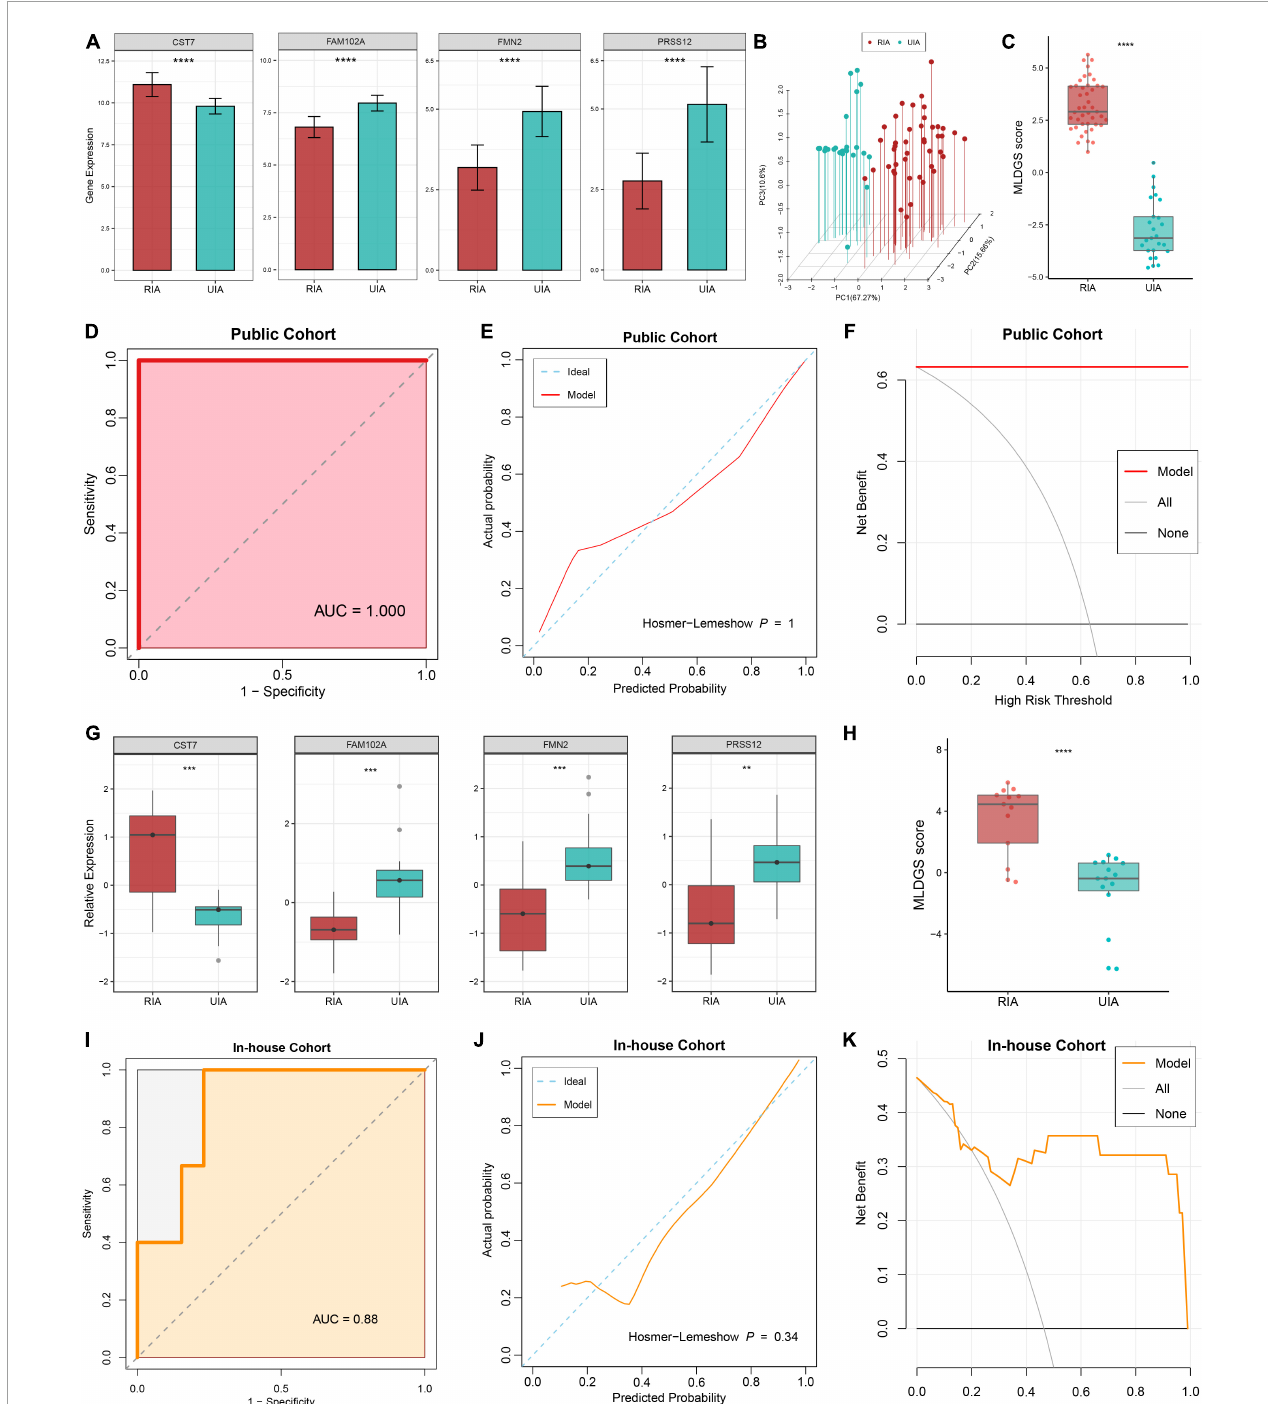
FIGURE4 Evaluation and validation of the MLDGS model. (A) Differential expression of four model genes between RIA and UIA groups in public cohort. (B) Principal component analysis showed that RIAs and UIAs could be well distinguished based on the four model genes. (C) The distribution of MLDGS score between RIA and UIA groups in public cohort. D-F. ROC curve (D) , calibration curve (E) and decision curve (F) for the MLDGS to identify RIAs in public cohort. (G) Relative expression of four model genes between RIA and UIA groups in our in-house cohort. (H) The distribution of MLDGS score between RIA and UIA groups in our in-house cohort. (I–K) ROC curve (I) , calibration curve (J) and decision curve (K) for the MLDGS to identify RIAs in our in-house cohort. Statistic tests: two-sided t -test. ns P > 0.05, * P < 0.05,** P < 0.01, *** P < 0.001, and**** P < 0.0001.